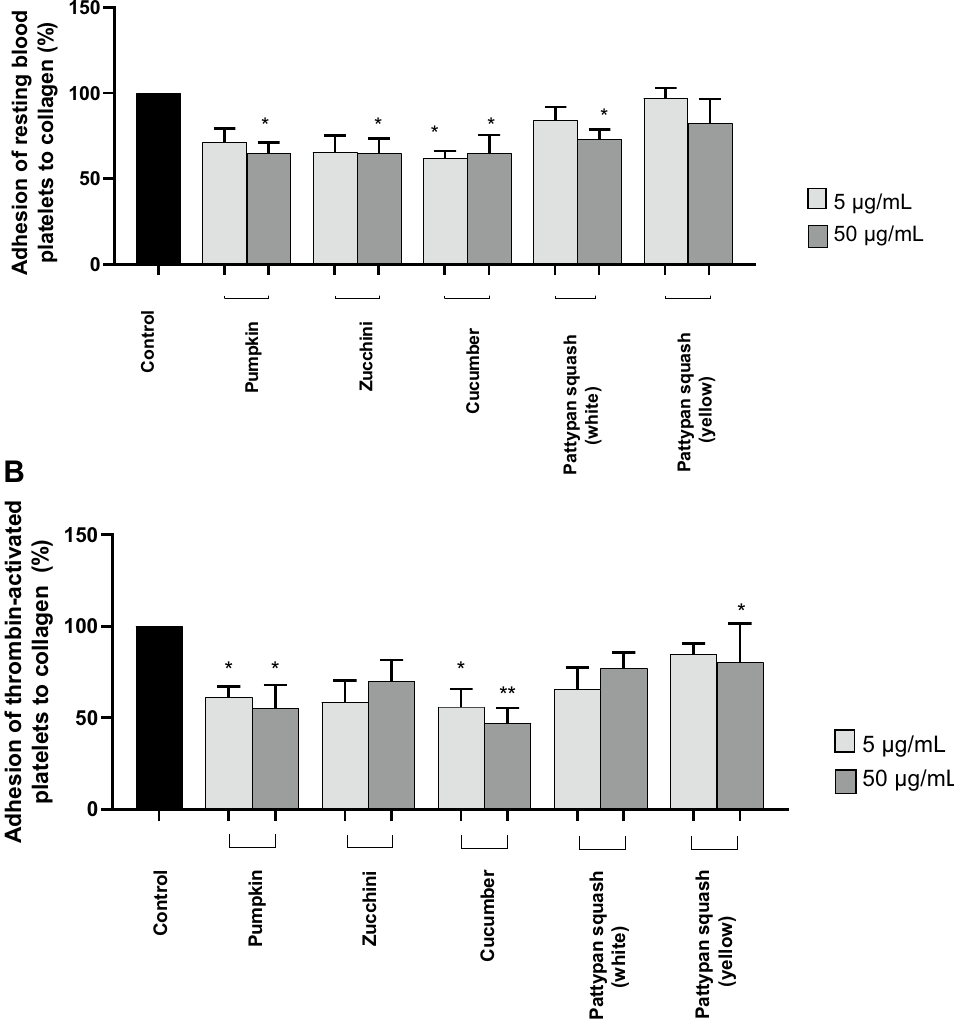
Figure 2. Effects of the five cucurbit vegetable preparations (concentrations 5 and 50 µg/mL, incubation time— 30 min) on adhesion of resting platelets to collagen ( A ) or thrombin (final concentration 0.2 U/mL)—activated platelets ( B ). In the graphs, the adhesion is expressed as a percentage of the control sample (platelets without plant preparation). Results are given as mean ± SD (n = 5). Kruskal–Wallis test: *p < 0.05, **p < 0.01, compared with control (i.e. not treated with plant preparation). There wasn’t any statistically significant between effect of 5 and 50 µg/mL (p > 0.05). The baseline spectral reading (absorbance) for plant preparations range between 0.00075 and